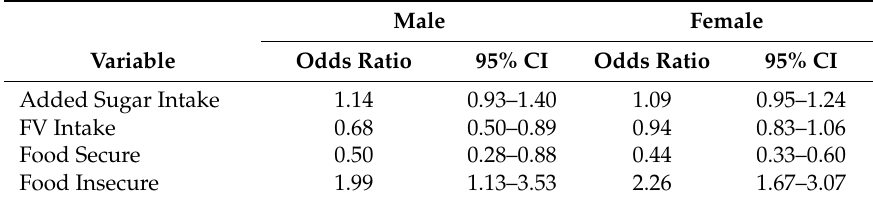
Table 3. Logistic Regression model predicting depression status in male and female students.